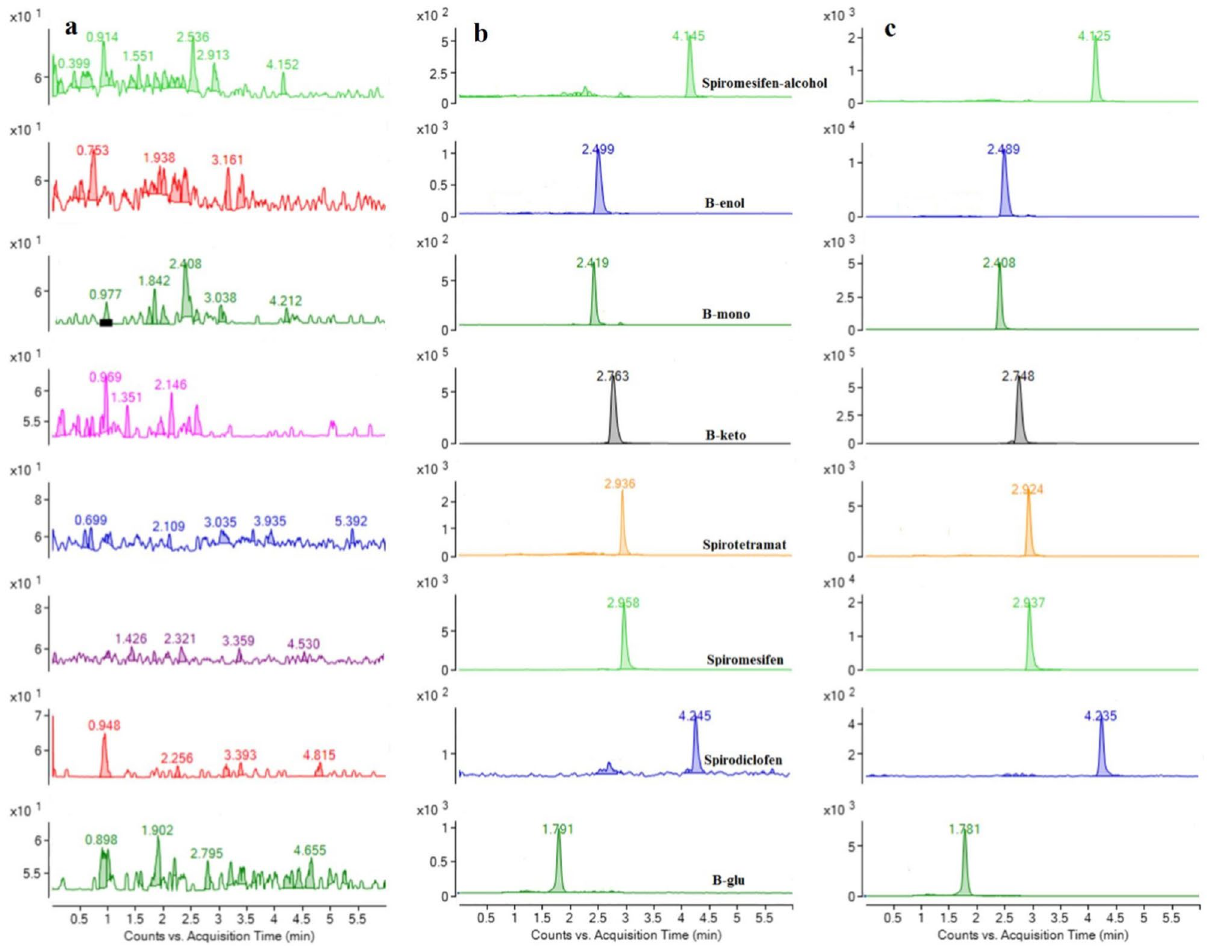
Figure 1. UHPLC–MS/MS chromatograms of spirodiclofen, spiromesifen, and spirotetramat and their relevant metabolites of ( A ) blank Pleurotus ostreatus sample, ( B ) Pleurotus ostreatus spiked at 100 μg kg −1 , ( C ) standard (100 μg kg −1 ).